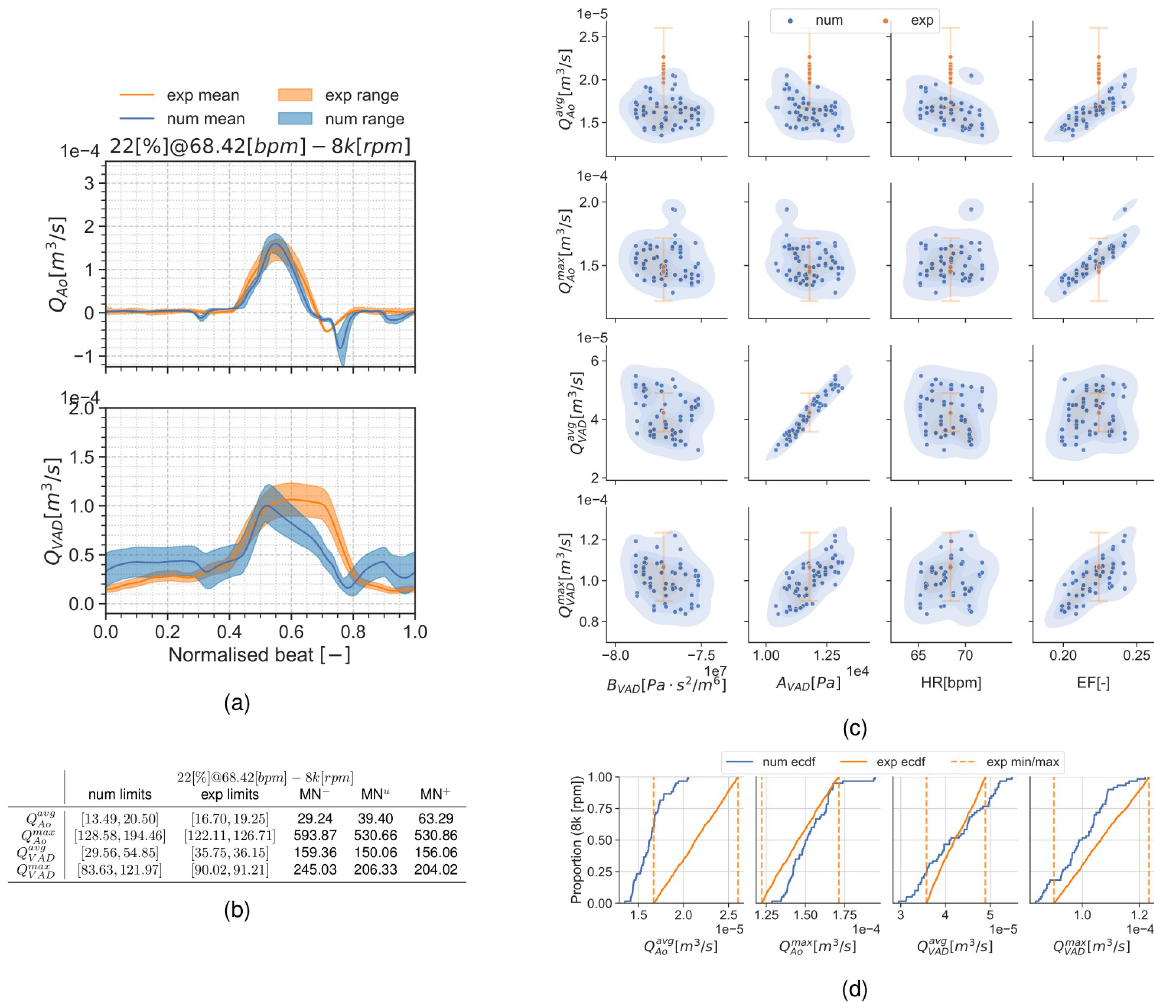
Fig 6. Summary for the condition 22[%]@68.42[ bpm ] and 8 k [ rpm ]. (a): aortic valve and LVAD flows. (b): validation metrics. (c): scatter plot showing the simulation and experimental data. (d): ECDF for the simulation, experimental data limits and the constructed uniform distribution.